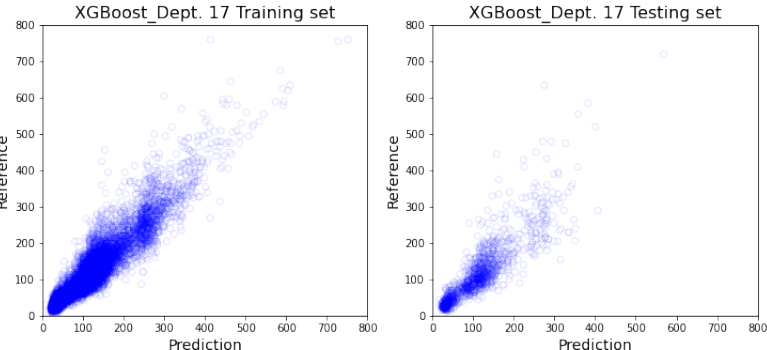
Figure A15. Model Performance of XGBoost on Dept.17. The visualization of training and testing data for department specific model on department 17 with